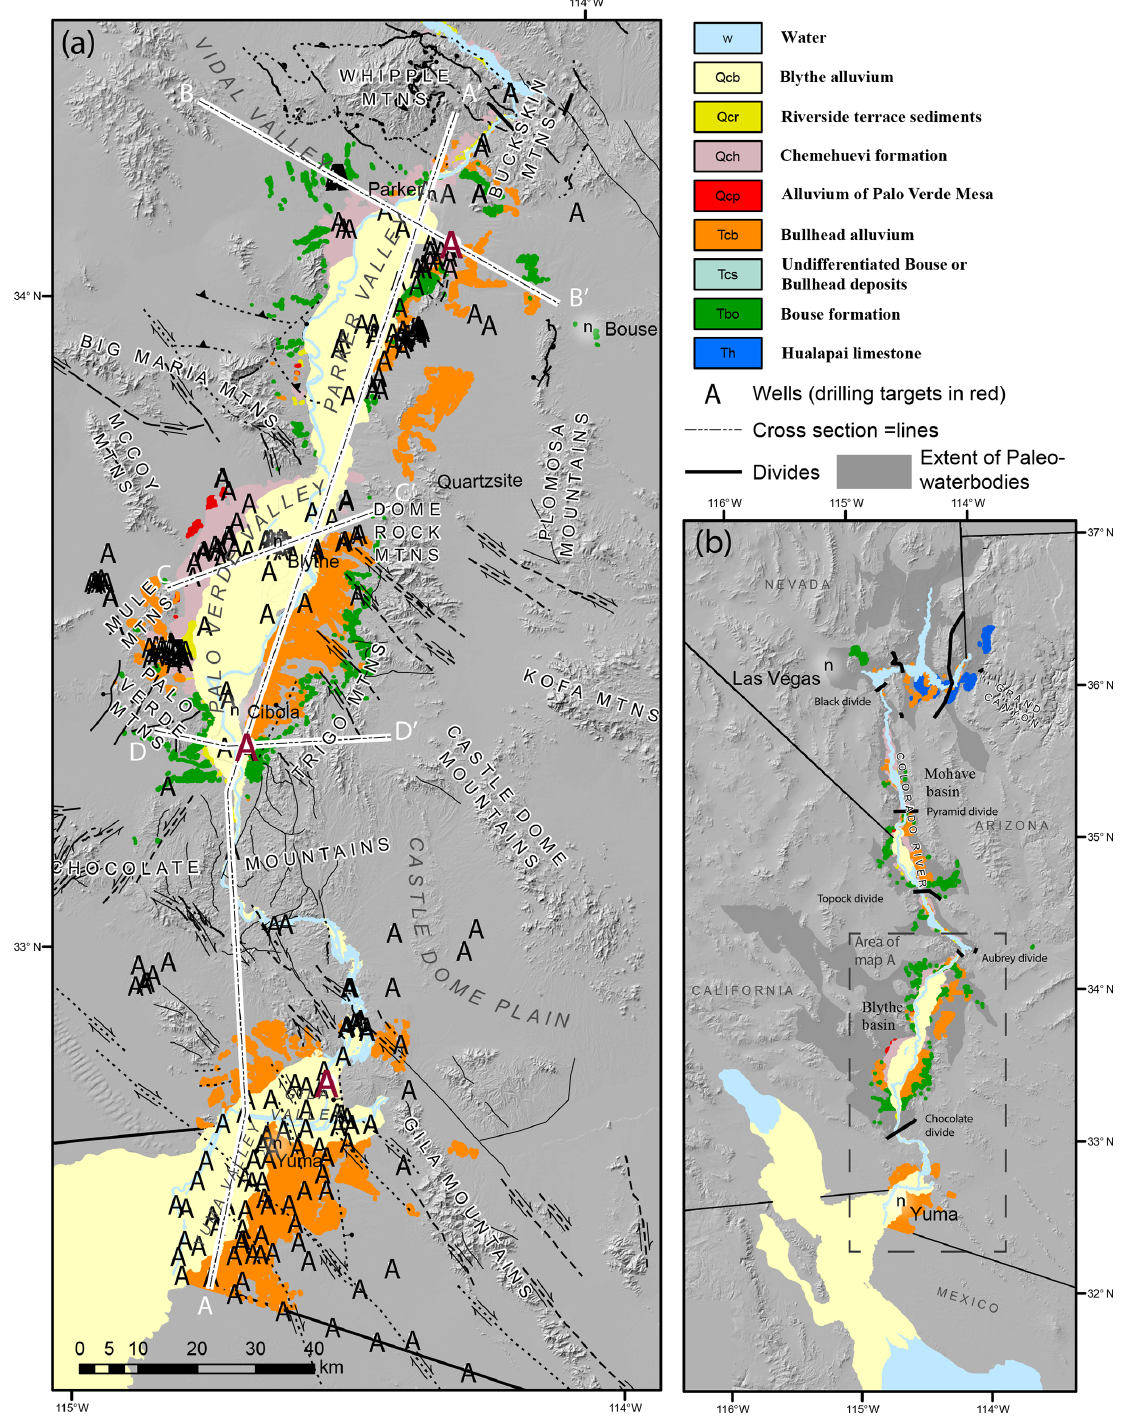
Figure 2. Geological index maps of (a) the Blythe basin study area and (b) the regional setting of the Blythe basin with respect to geologic elements of the Colorado River corridor and the Gulf of California, showing the reconstructed outlines of paleo-water bodies for the Bouse deposystem in darker gray and basin spillover locations with black lines. Panel (a) shows the outcrop distribution of stratigraphic units discussed in the text (modified from Crow et al., 2018), locations of prior water/geotechnical wells with cuttings/log records available for this study and cross sections illustrated in Fig. 4. Most discussion on target localities for drilling have focused on the well exposed and controversial Bouse Formation rocks of the Blythe basin. Potential and promising drill sites were also examined in the Yuma basin, south of the Chocolate Mountains basinal divide. Provisional drilling target areas are shown but additional site survey work is required prior to final site